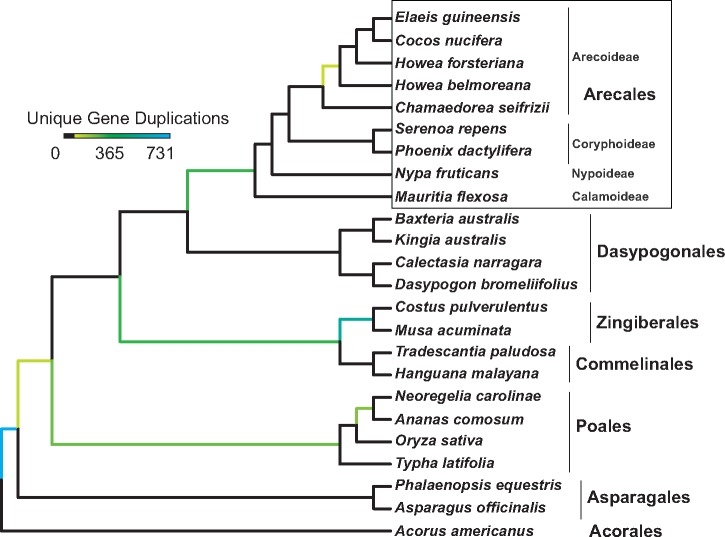
—Phylogenomic evidence for a whole-genome duplication event in the ancestor of all palms. The color bar represents the number of unique gene duplications placed at each node, with at least 80% bootstrap support. The tree has representatives of 4/5 palm subfamilies (Calamoideae = Mauritia; Nypoideae = Nypa; Coryphoideae = Phoenix, Serenoa; Arecoideae = Chamaedorea, Cocos, Elaeis, Howea).